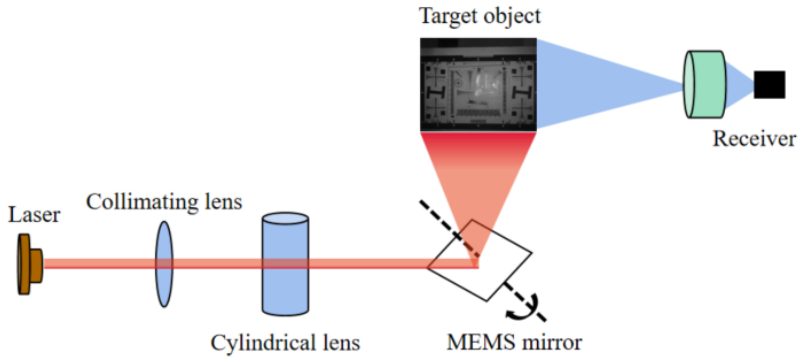
Figure 1. Schematic diagram of laser-structured light projector and imaging receiver.